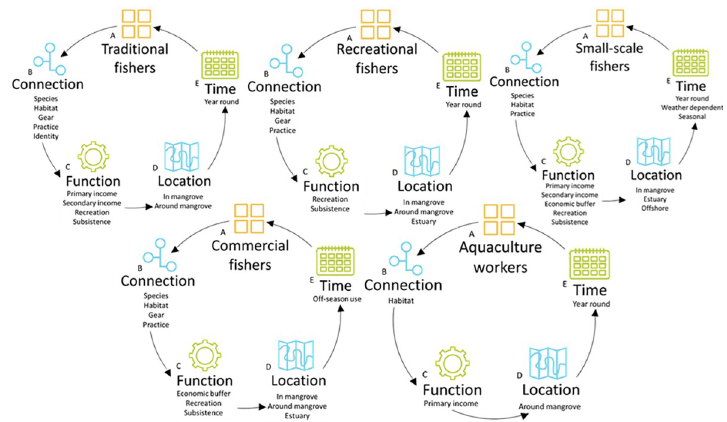
Fig 2. The typology of the Perancak Estuary mangrove-fishery, describing how fishers use mangroves, by A) sector, through dimensions of B) connection with the mangrove, C) function of fishing and D) location of fishing and E) time scale of mangrove-associated